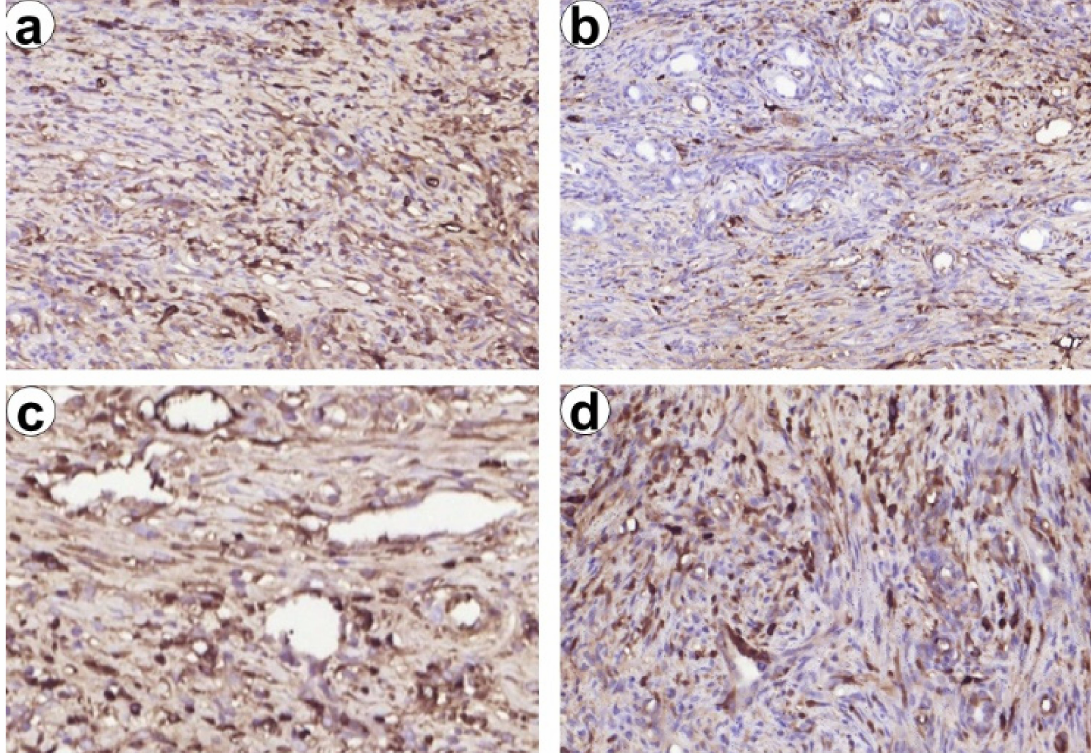
Figure 10. Infiltration of the capsule surrounding chitosan-based materials with CD68+ and CD163+ macrophages ( a , b ) and lymphocytes ( c , d ) in 7 days after hemostasis. Immunohistochemical study. ( a ) Numerous diffusely spread CD68+ cells in the capsule surrounding liver defect filled with hemostatic material. ( b ) CD163+ cells concentrating predominantly around vessels and cholangioles reflecting their association with repair. ( c , d ) CD8+ and FOXP3+ lymphocytes in the capsule surrounding liver defect filled with hemostatic material, Magnification 200 ×